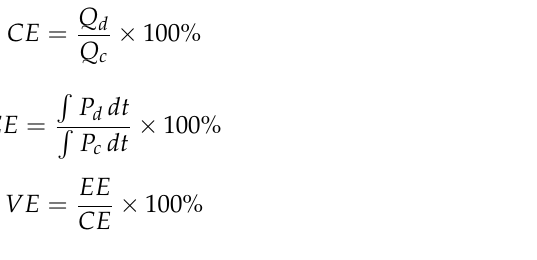
Table 3. Analysis of charge-discharge cycling for Cells 9 and